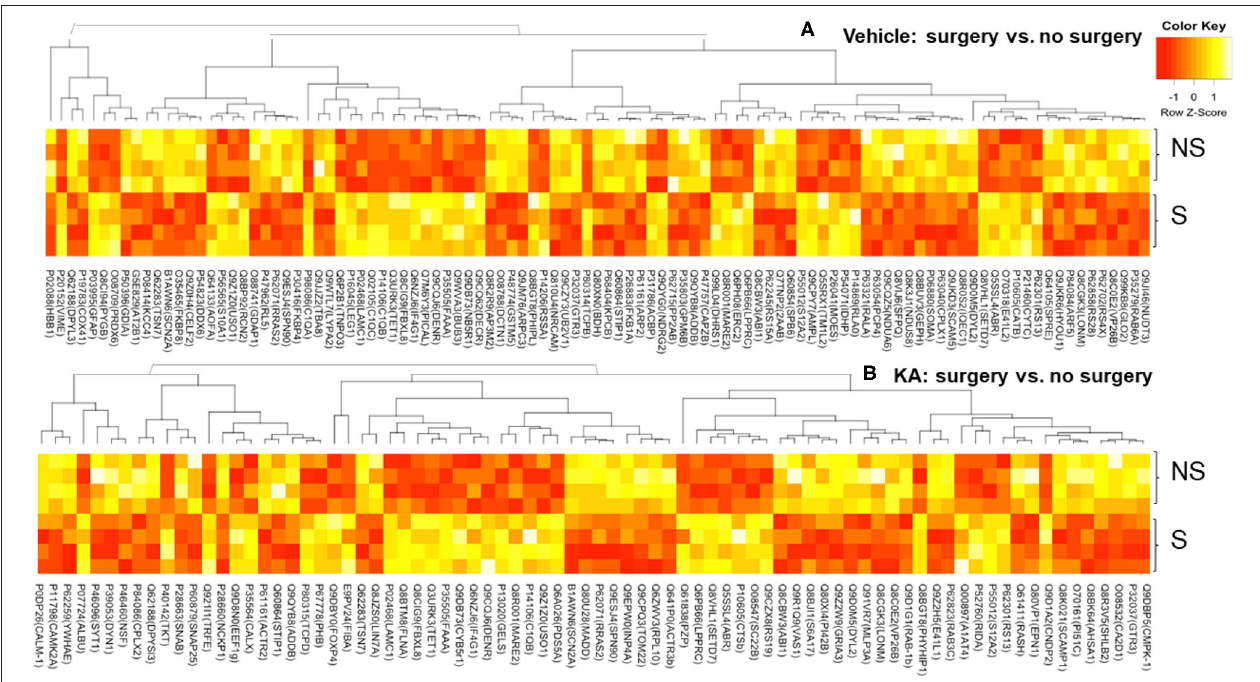
FIGURE 4 | Heatmaps—an overview of the variation in proteins between surgery and no surgery groups treated with either vehicle (A) or KA (B) . NS, no surgery; S, surgery.